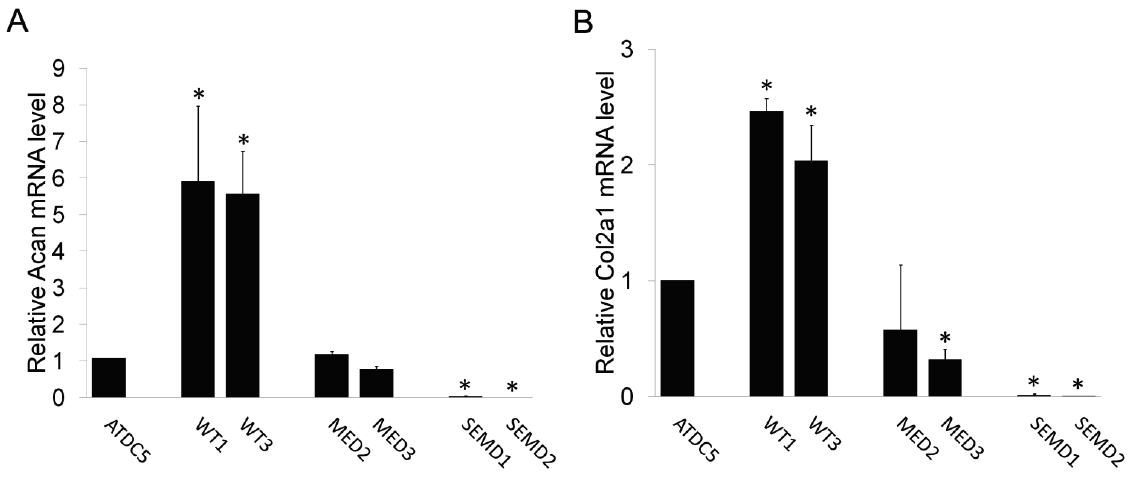
Figure 6. Low and high expression clones of WT and mutant MATN3 transfected cell lines show similar trend of chondrogenesis marker expression. ( A ) Gene expression of aggrecan and ( B ) type II collagen in low and high expression WT or mutant MATN3 stably transfected ATDC5 cell lines as analyzed by real time RT-PCR 24 h post seeding. * p ≤ 0.05 vs. untransfected ATDC5